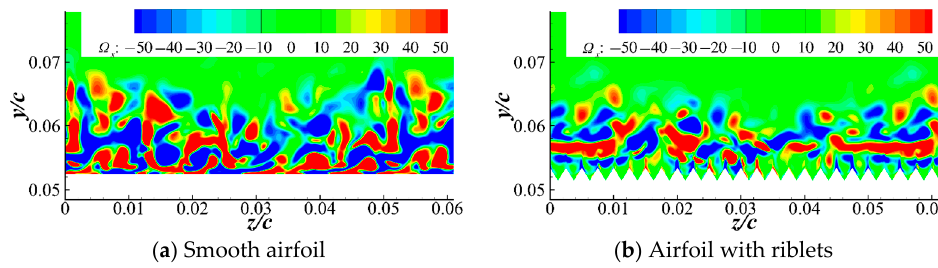
Figure 18. Instantaneous streamwise vorticity contours at x / c = 0.6.